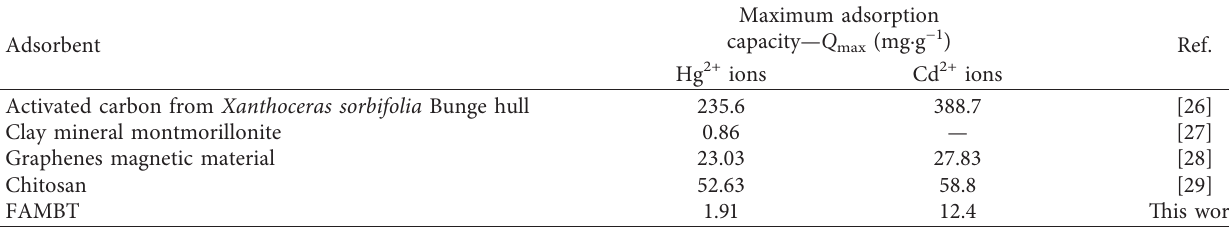
max ) of different adsorbents for Hg